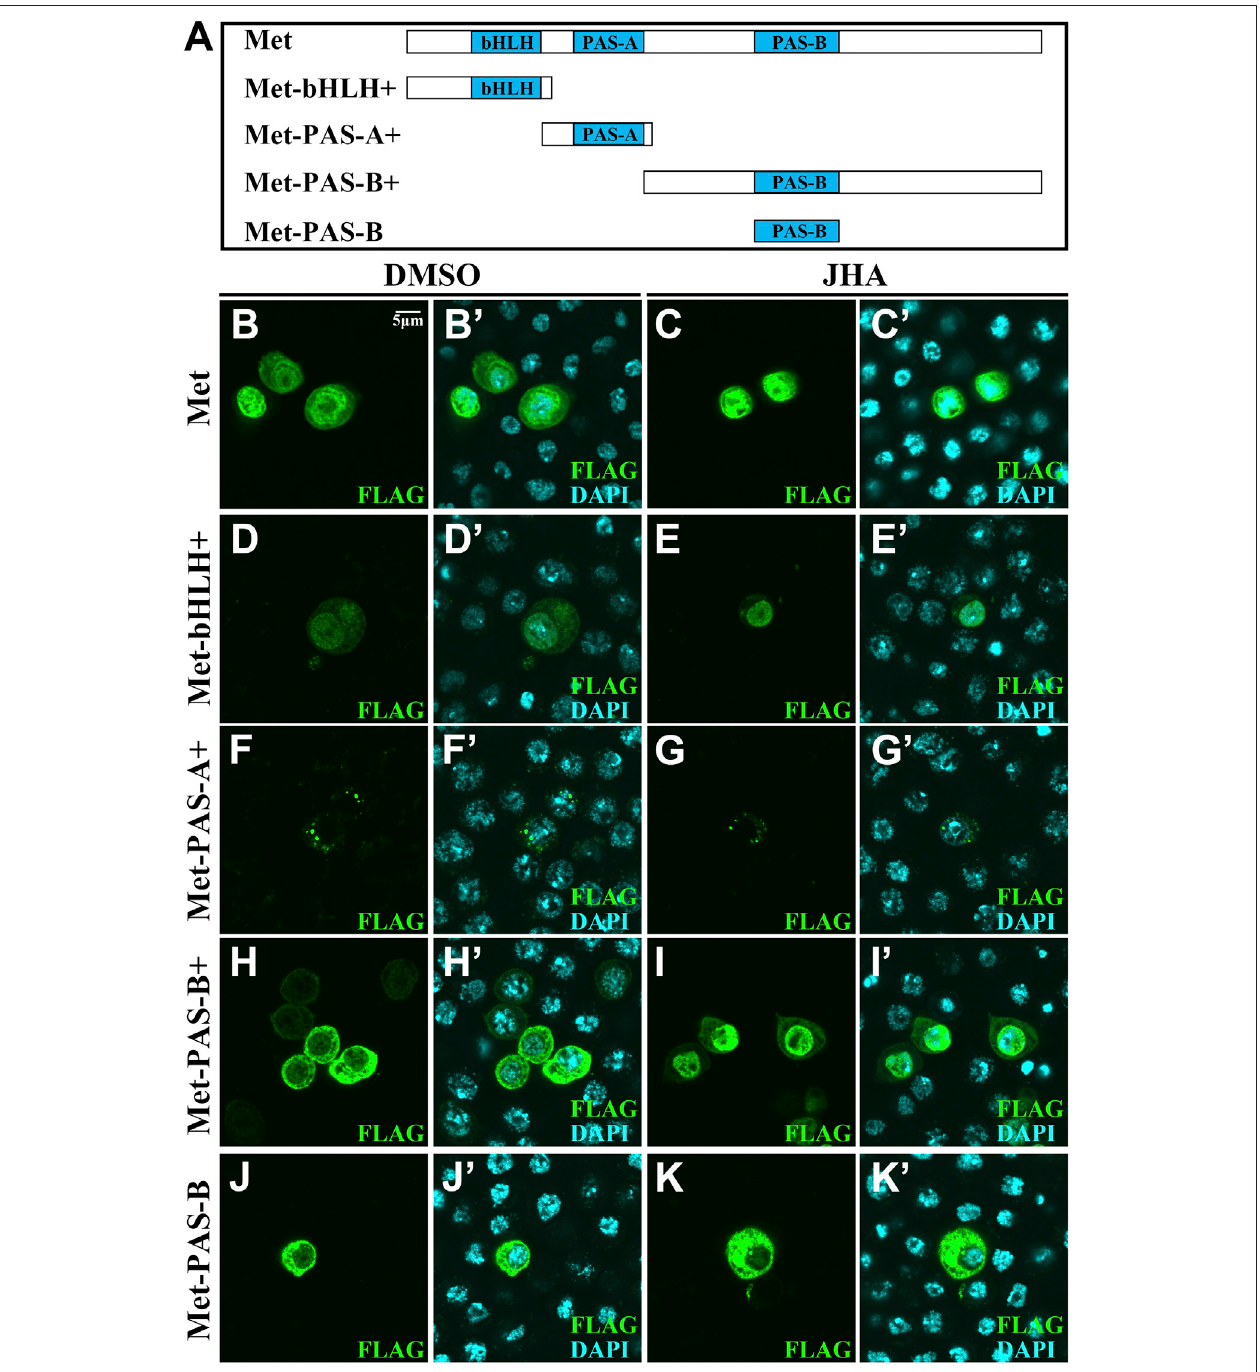
FIGURE 3 | Subcellular localization of distinct fragments of Met with a FLAG tag in Kc cells. (A) Scheme illustrating the full-length and truncated mutants of Met. (B – K ’ ) Localization of full-length or truncated mutants of Met was not altered in the absence or presence of JHA except for Met-PAS-B+. Cells expressing full-length or truncated mutants of Met were stained for FLAG (green). Merge images also present nuclear staining with DAPI (blue).